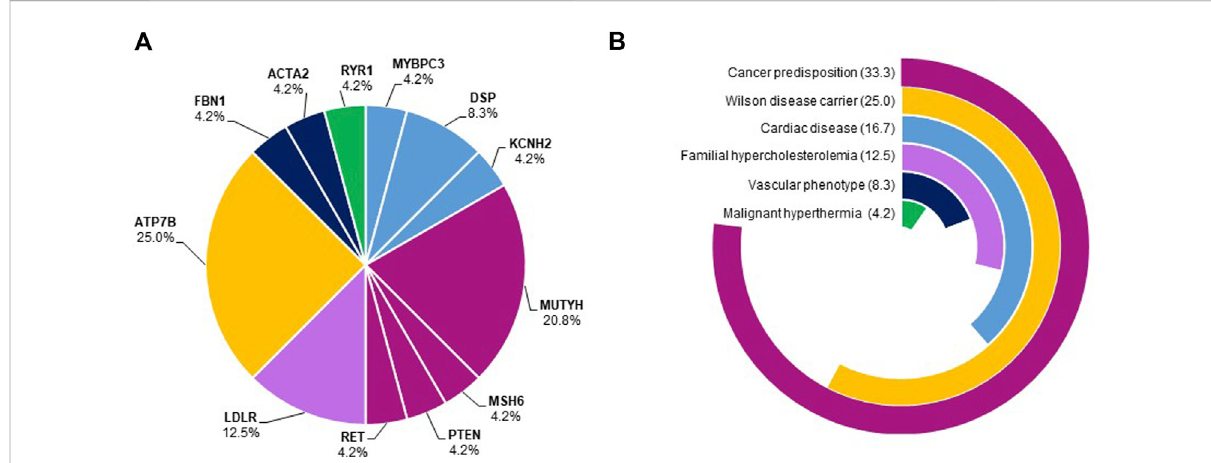
FIGURE 2 Frequency of genes harboring secondary fi ndings and disease domains. Panel (A) . The pie chart shows the frequency of genes harboring SFs. GenesbelongingtothesamediseasedomainwereshownusingthecolorcodereportedinpanelB.Panel (B) .Thepiechartshowstheproportionsof disease domains of identi fi ed SFs. The most frequent disease domains were cancer predisposition (33.3%), cardiac diseases (16.7%), and familial hypercholesterolemia